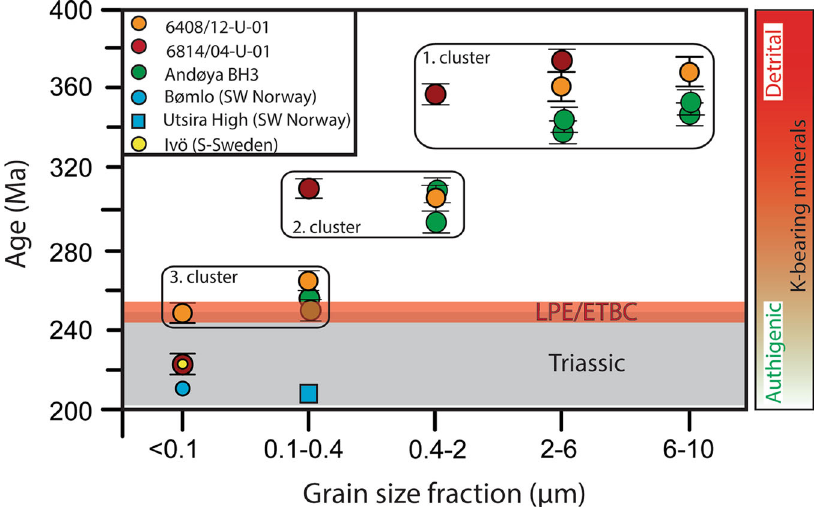
Fig. 7 Interpretation of K-Ar geochronological data. K-Ar ages in various grain size ( µ m) fractions with three different age clusters (1 – 3) as discussed in the main text. K-Ar age errors (bars) are within 1 σ uncertainties (see Table S3). A single late Triassic age (221.5 Ma) in the fi nest fraction of well 6814/04- U-01 corroborates within error published results of weathered basements in southern Sweden (Ivö) (221.3 Ma) (yellow circle) 20 . Published ages for the fi nest fraction in SW Norway (Bømlo, Utsira High) are shown by the light blue circle and rectangle 20 . On the right, relative proportions of detrital and authigenic K-bearing minerals for each cluster are